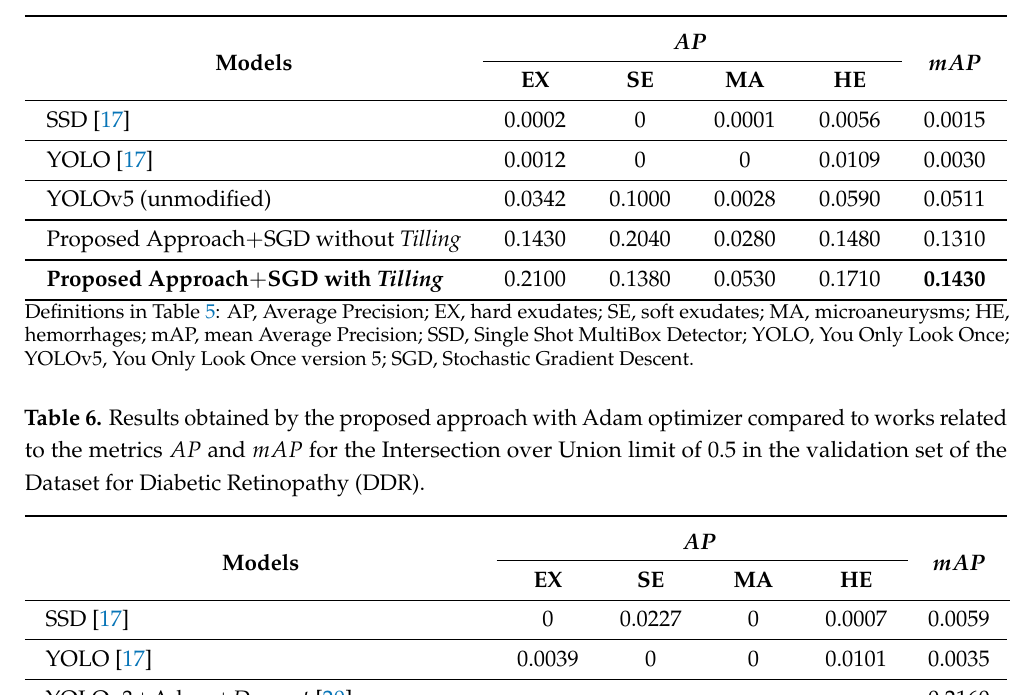
Table 5. Results obtained by the proposed approach with SGD optimizer compared to works related to the metrics AP and mAP for the limit of Intersection over Union of 0.5 in the test set of the Dataset for Diabetic Retinopathy (DDR).